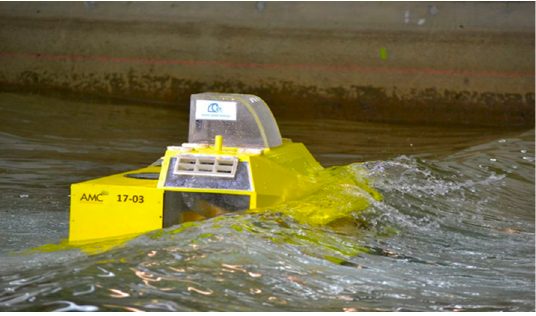
Figure 2. Model scale experiments performed in the Australian Maritime College’s Model Test Basin [7].